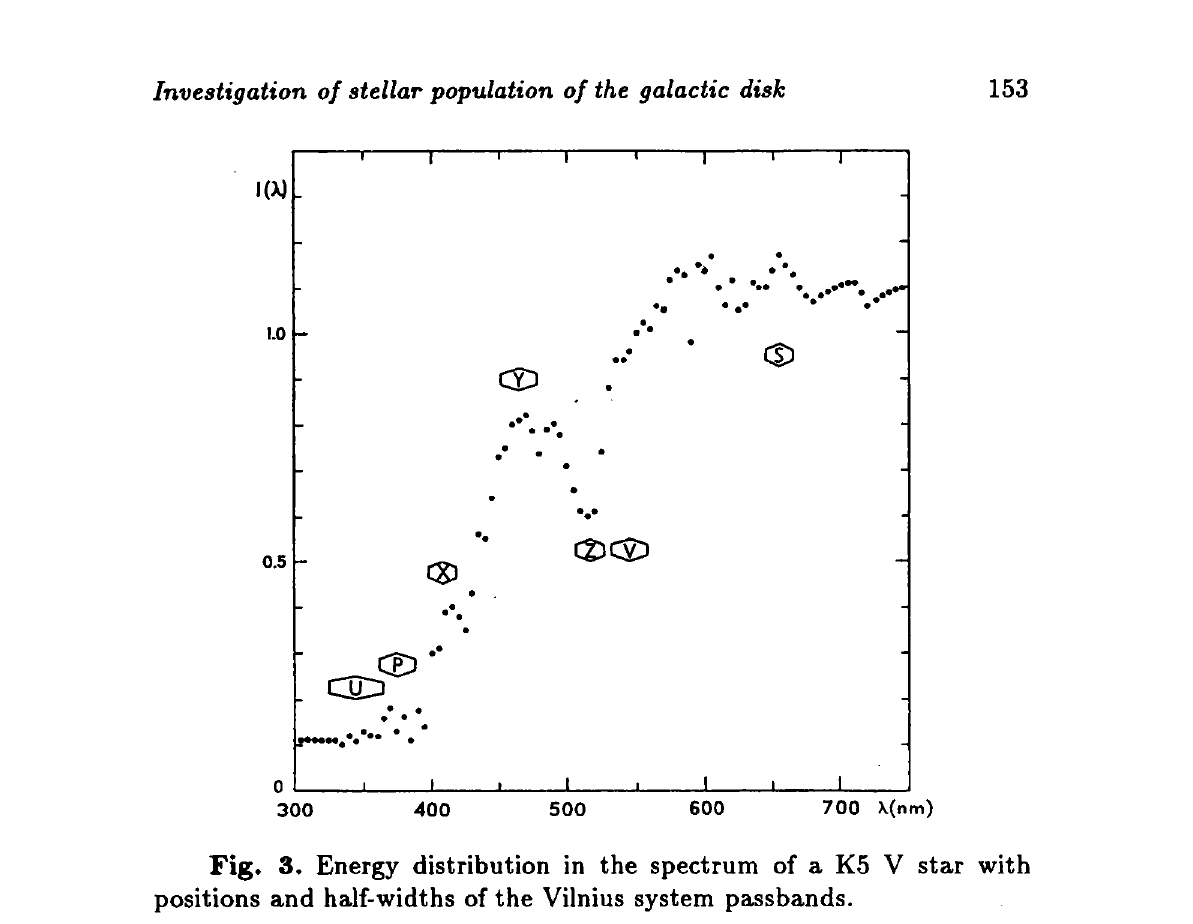
Fig. 3. Energy distribution in the spectrum of a K5 V star with positions and half-widths of the Vilnius system